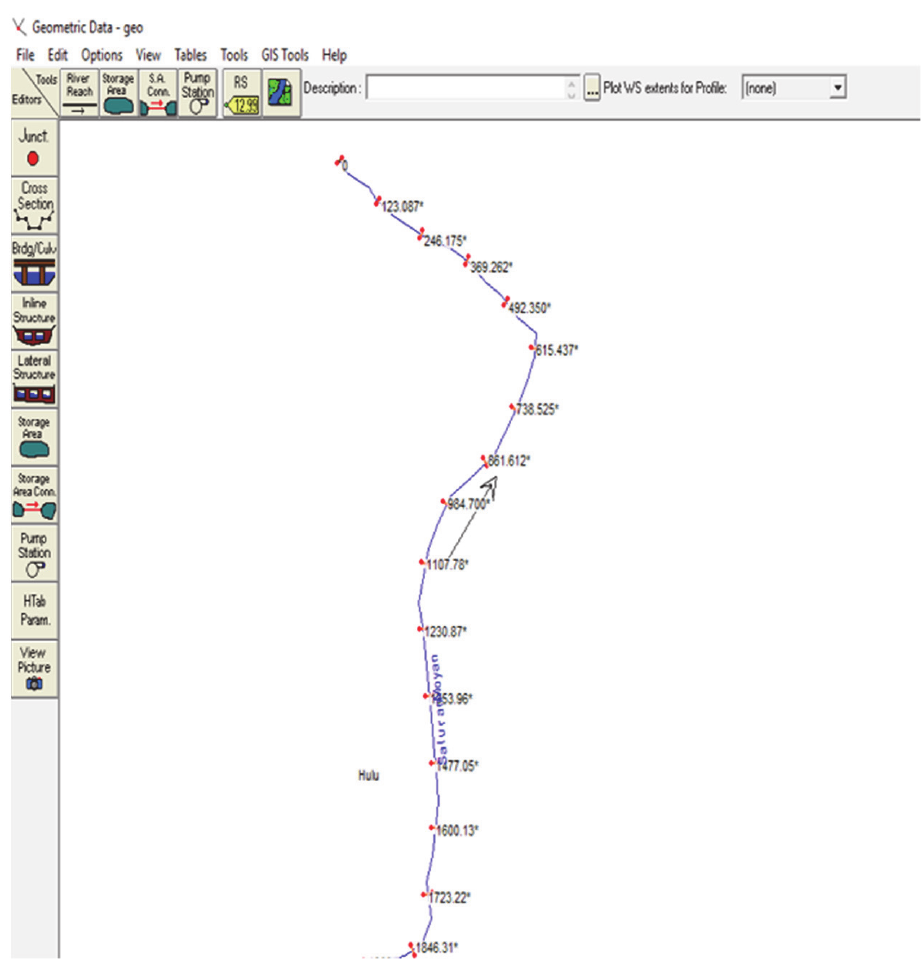
Figure 5. Moyan Irrigation Geometry Menu.